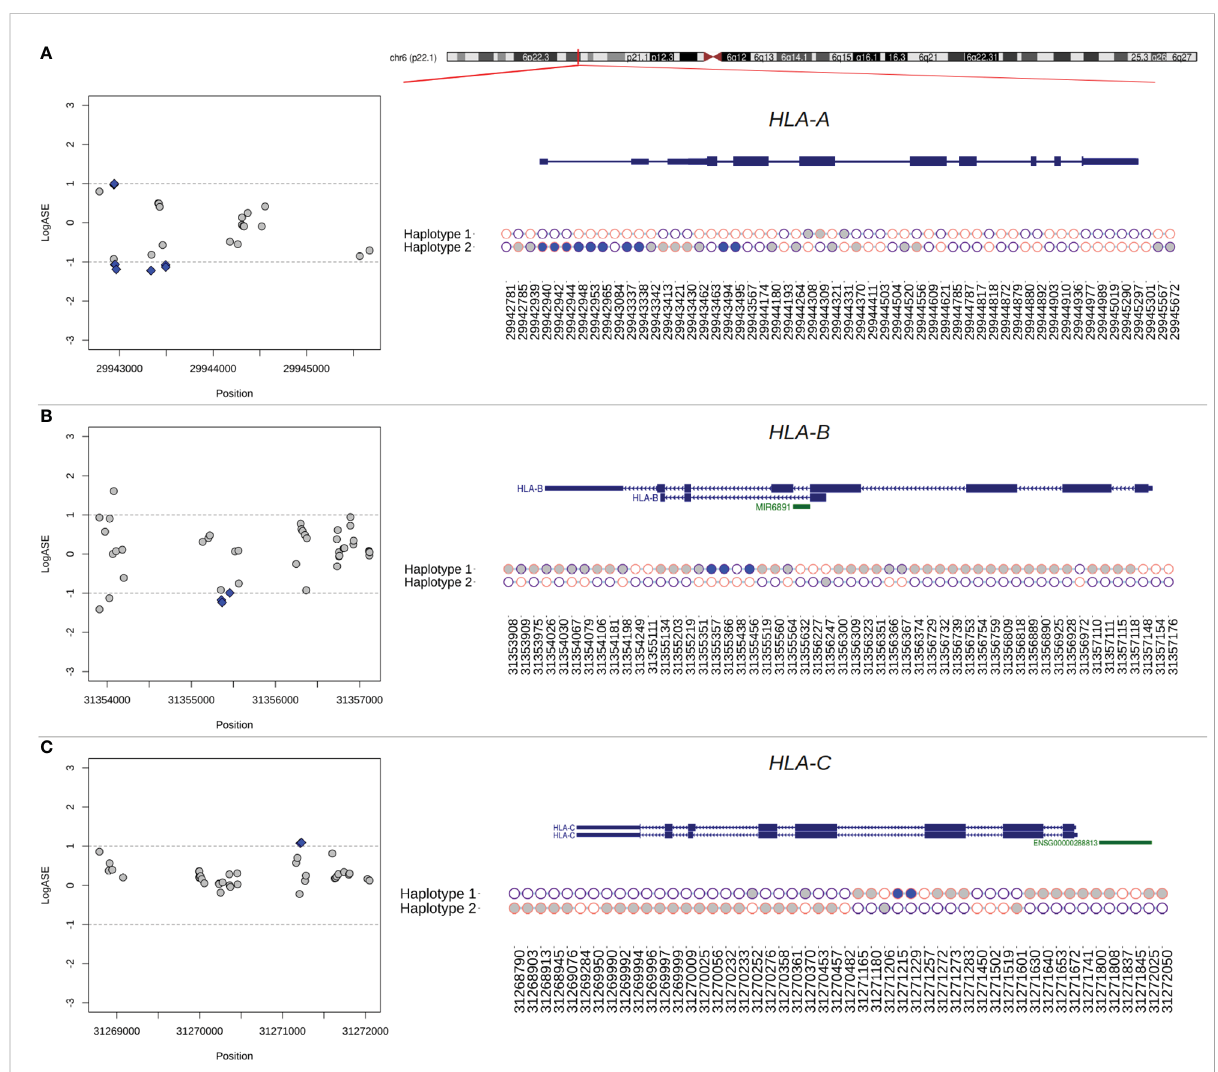
FIGURE 4 Phasing of DASE sites and co-localized eSNVs from classical MHC class I genes using RNA-seq data from Calu-3 cells. (A – C) Regional plot of eSNVs localized around the HLA-A , -B , and -C genes. In blue, DASE sites revealed by the binomial test. The gray represents the other eSNVs tested that did not reach statistical signi fi cance. The ideogram of the chromosome is also shown, and a red tick shows where each relevant transcript isoform is located. Next, a plot showing the single haplotype block spanning the genes under analysis. Purple circles represent the reference allele, while the alternative is represented in pink. The x-axis refers to the genomic position of each eSNV in the GRCh38 genome assembly, and the y-axis shows the two haplotypes from the chromosomal locus. Blue and gray circles matched the SNVs in the regional plot on the left. The SNVs found in HLA genes that were not used in the binomial test are shown by the empty